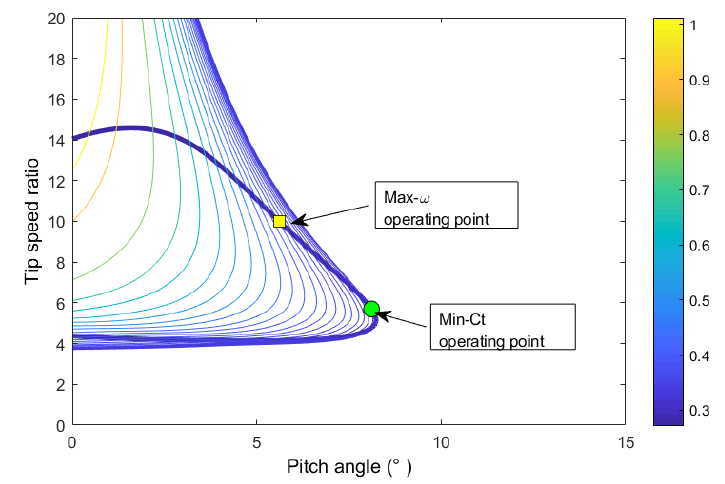
Figure 5. Operating points in the Max- ω strategy and the Min- C t strategy.